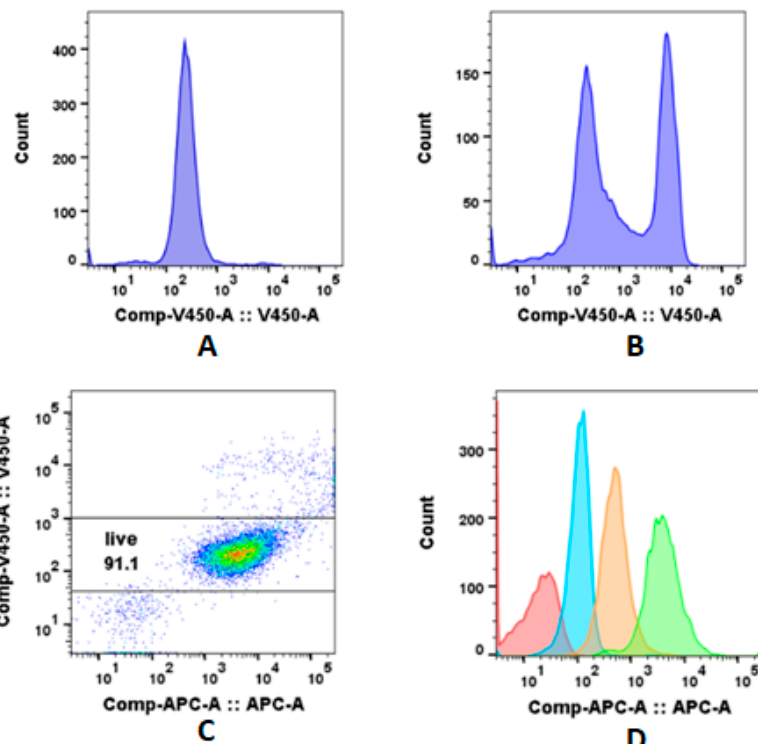
Figure A2. Comparison of size exclusion chromatography (SEC) chromatograms obtained from the refractive index (RI) detector. Polymer precursor 1 (yellow curve), polymer conjugate REF (purple curve), and CPP–polymer conjugates TAT12 (orange curve) and PEN12 (blue curve).